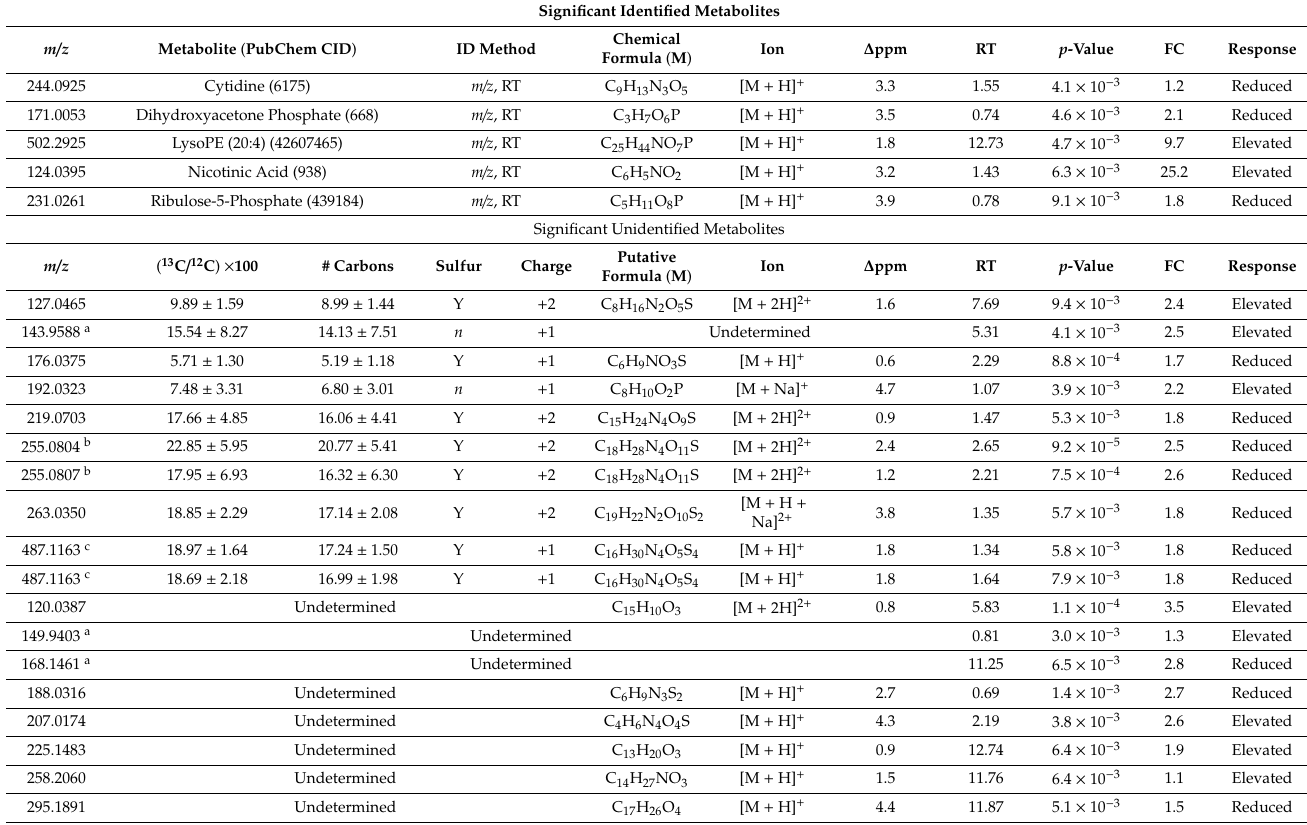
Table 1. Significant ( p < 0.01) identified and unidentified metabolite features in the mouse distal colonic mucosa after oral gavage with O. formigenes . Identified metabolites: information regarding their detection and identification ( m / z , RT, ion / adduct, mass accuracy, PubChem CID), significance ( p -value, fold-change), and response to O. formigenes gavage (elevated or reduced signal intensity compared to the control) are shown. Unidentified metabolite features: information regarding their detection ( m / z , RT, ion / adduct, mass accuracy), putative formula assignment (based on m / z matching within 5 ppm), significance ( p -value, fold-change), and response to O. formigenes gavage (elevated or reduced signal intensity compared to the control) are shown. For select unidentified features, chemical information gained from isotope ratio analysis (# carbons, presence of sulfur, charge state) is presented. Assigned putative formulas and ions for these features agree with their associated isotope